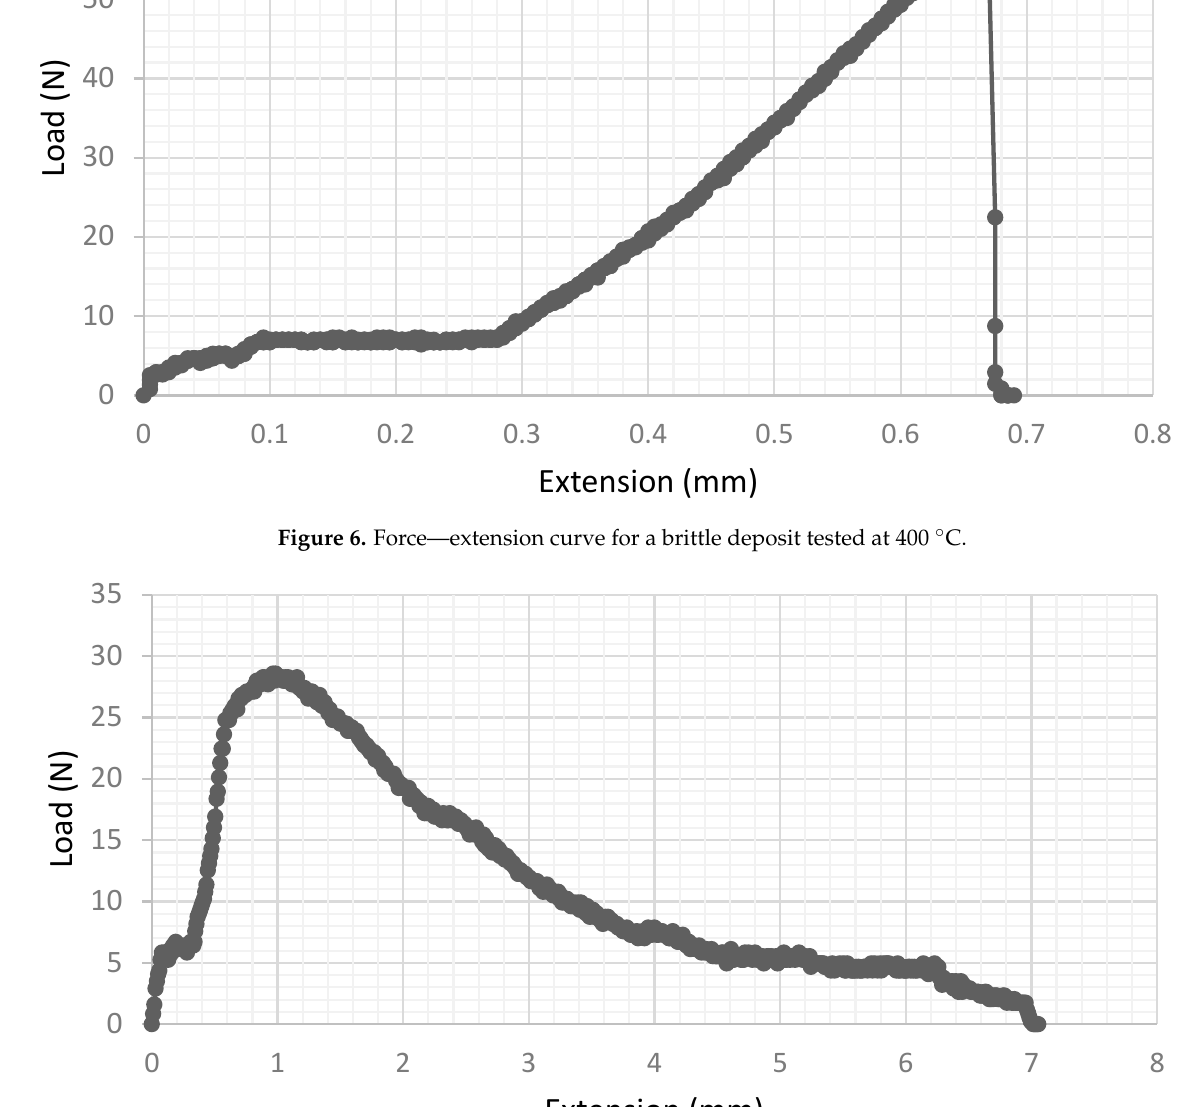
Figure 7. Force–extension curve for a ductile deposit tested at 460 °C. Time lapse images of the two types of fracture are shown in Figure 8. For the brittle specimen tested at 400 °C, there was no crack extension until the instant of complete frac ‐ ture. For the ductile specimen, tested at 460 °C, the crack growth was stable. Both of these tests were run at a crosshead speed of 1 mm/min, so the time in minutes corresponds to a displacement in mm.